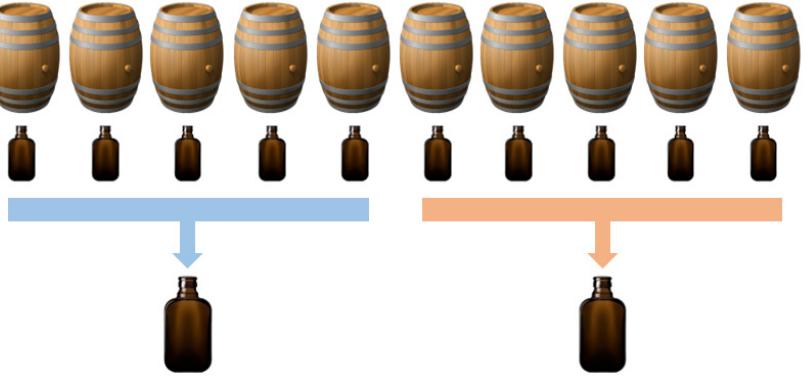
Figure 1. Experimental group of barrels (two set of five barrels) and definition of the sampling plan for the physical-chemical analysis. for the physical-chemical